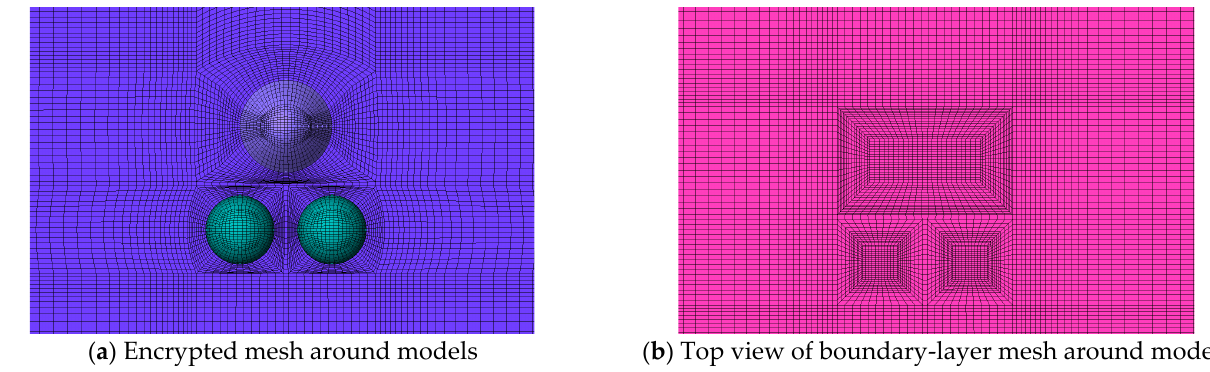
Figure 6. Hexahedral structure grid and boundary layer grid around wind tunnel model.